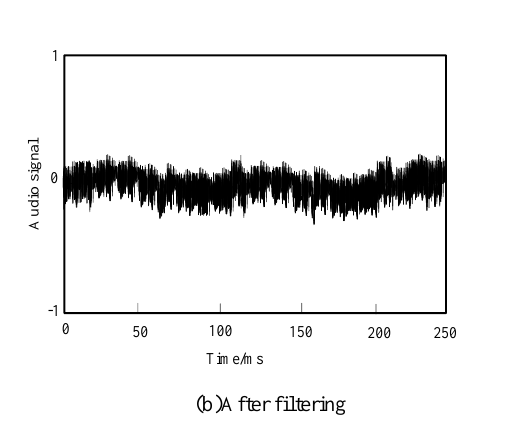
Figure 4. Music signal changes before and after filtering